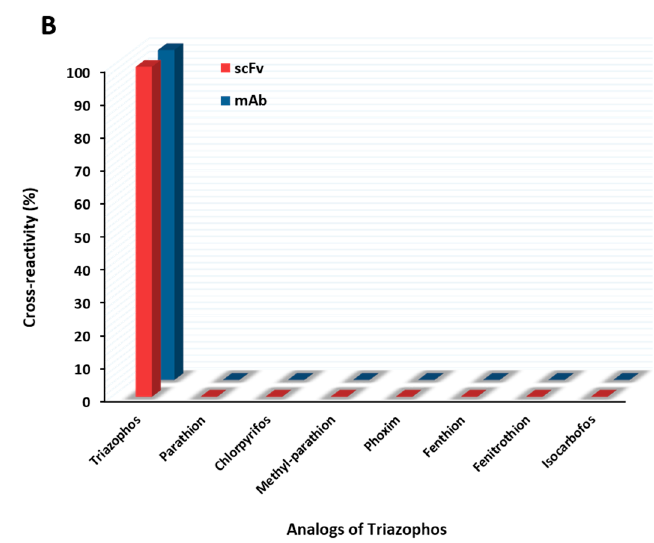
Figure 3. Ic-ELISAs (indirect competitive enzyme-linked immunosorbent assay) for triazophos detection ( A ) and CR of the other analogues ( B ) developed using the purified scFv-8C10 antibody with hapten THBu-OVA conjugate, compared with that of the intact parental antibody. The error bars represent standard deviations calculated from three replicate calibration curves obtained with the same sets of standards. Percentage of CR = [IC 50 of triazophos/IC 50 (analogue)] × 100%.